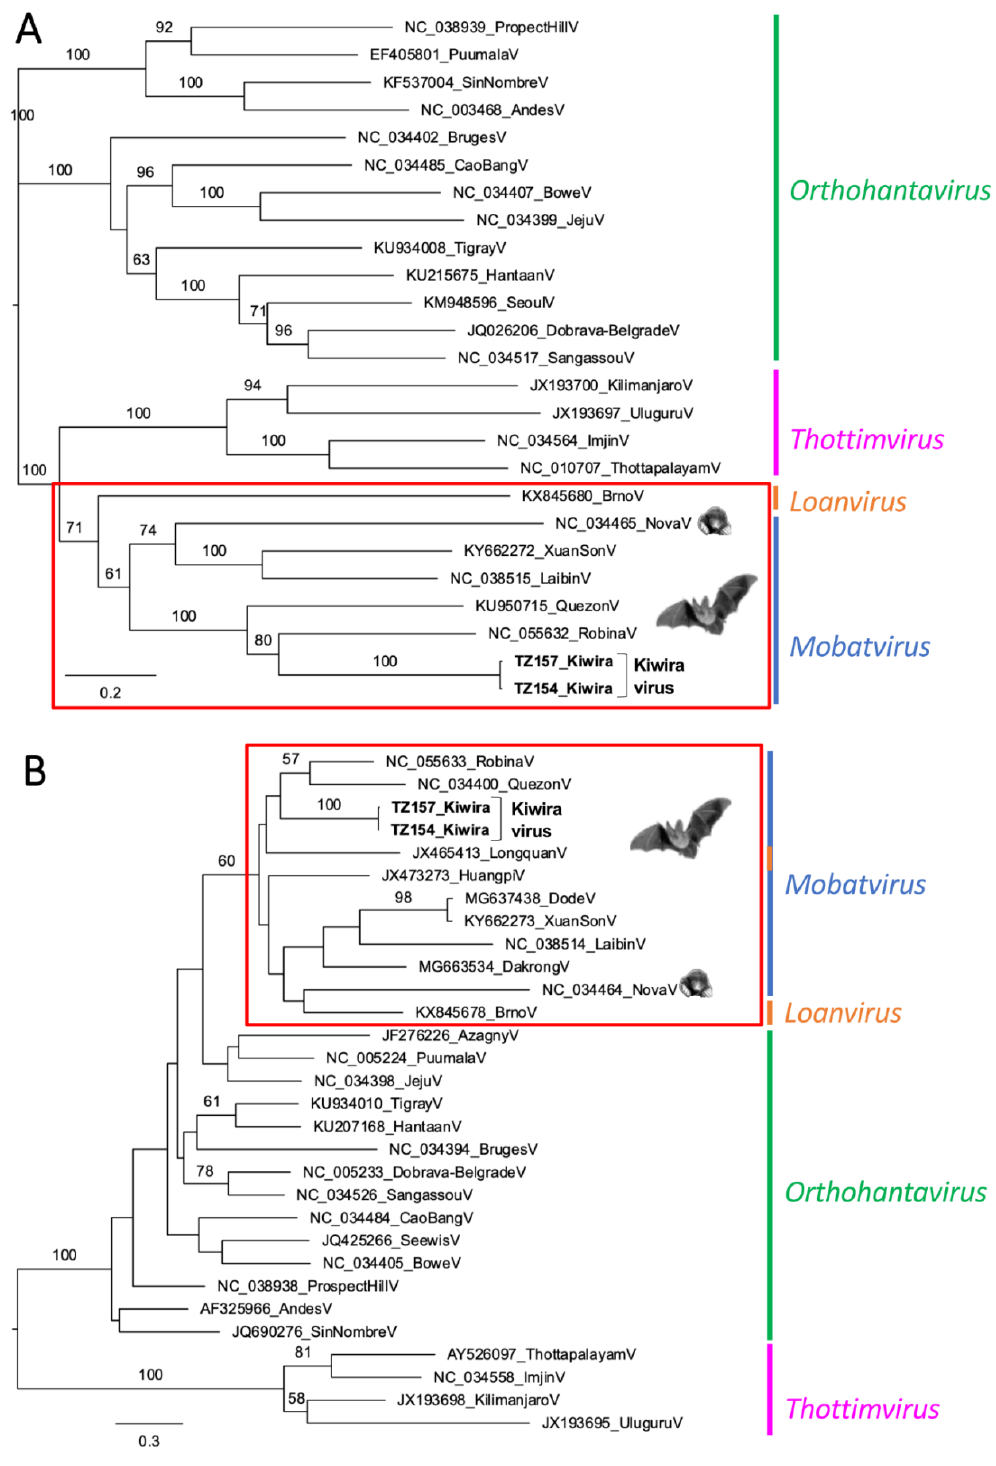
Figure 2. Maximum likelihood (ML) phylogenetic trees of partial L and S segments: ( A ) ML phy- logeny based on a 4826 nt alignment of the L segment, calculated using the GTR +I +G model; ( B ) ML phylogeny based on 308 nt alignment of the S segment, calculated using the HKY85 +I +G model. Scalebars indicate nucleotide (nt) substitutions per site. Bootstrap values are based on 1000 replicates and shown when above 50%. Viruses from this study are given in